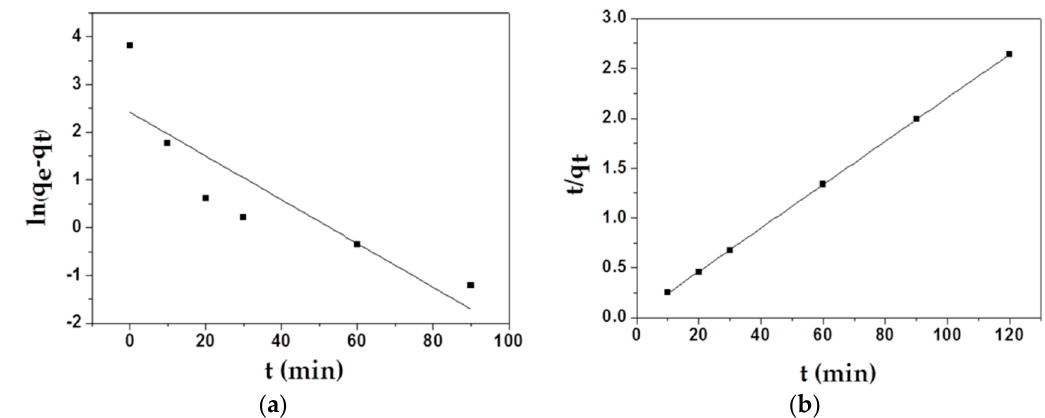
Figure 6. Kinetic fitting plots of the pseudo-first-order equation ( a ) for MAFC; kinetic fitting plots of the pseudo-second-order equation ( b ) for MAFC.